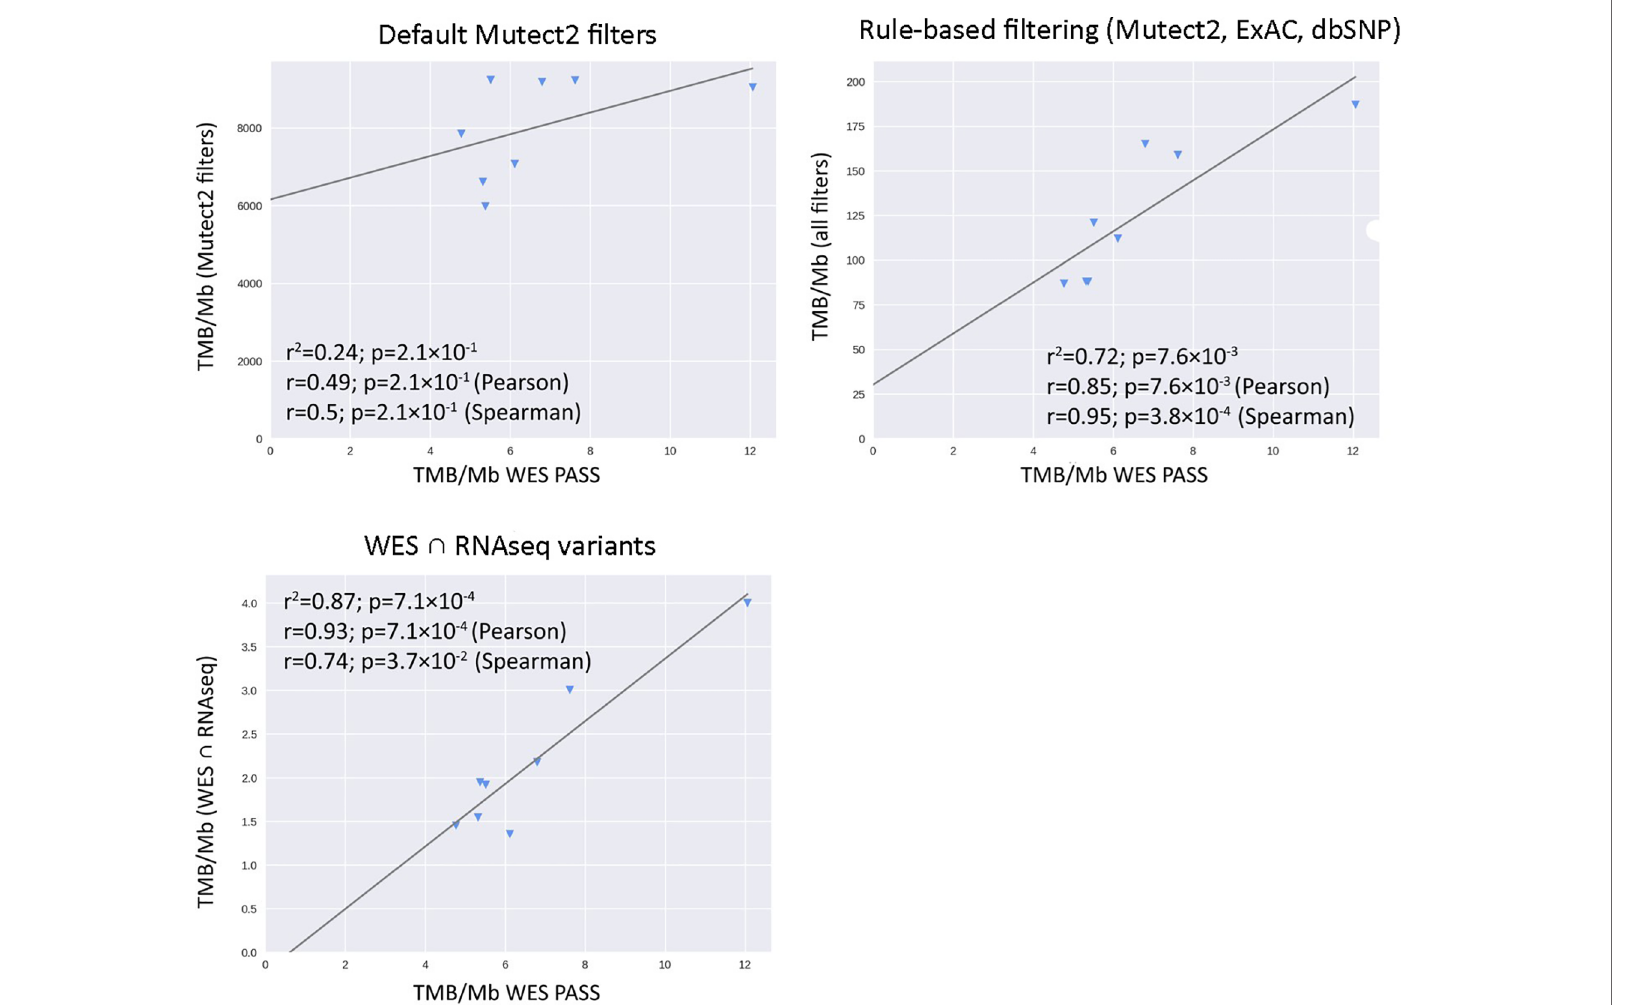
FIGURE 10 | Correlations between RNAseq- and WES-derived TMB estimates in experimental high coverage RNAseq dataset, n =